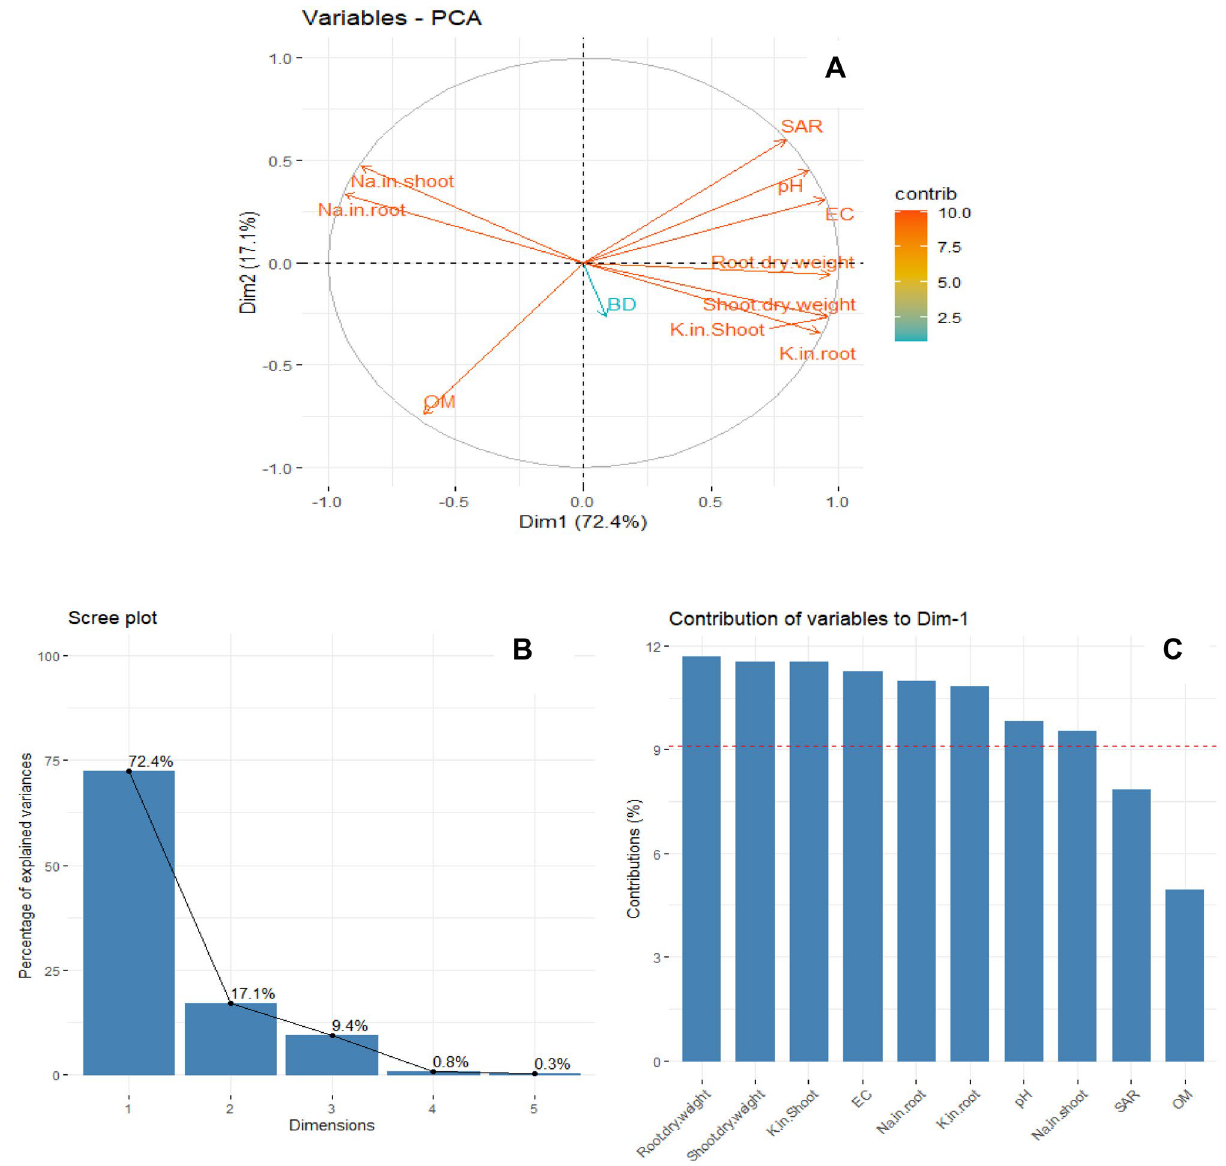
Figure 6. Principle component analysis (PCA) of soil physico-chemical properties, plant growth attributes, and ionic contents. ( B ) Percent variance explained by each dimension of PCA. The individual variability (%) explained by each dimension (Dim1 to Dim 5) was presented on each bar. C) Percent contribution of each variable to the first two dimensions of PCA. The dashed line depicts ~ 90% contribution to the significant